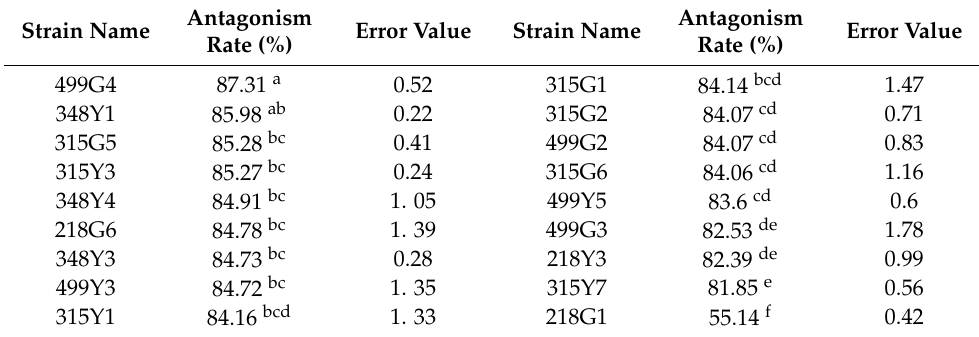
Figure 2. Antagonistic effect of the screened bacteria 499G4, 499G3, 348Y3, 315G5 and 315G6 on Magnaporthe grisea. Table 2. The antagonistic rate of bacterial cells to rice blast plate. Different lowercase letters show statistically significant difference ( p value < 0.05).